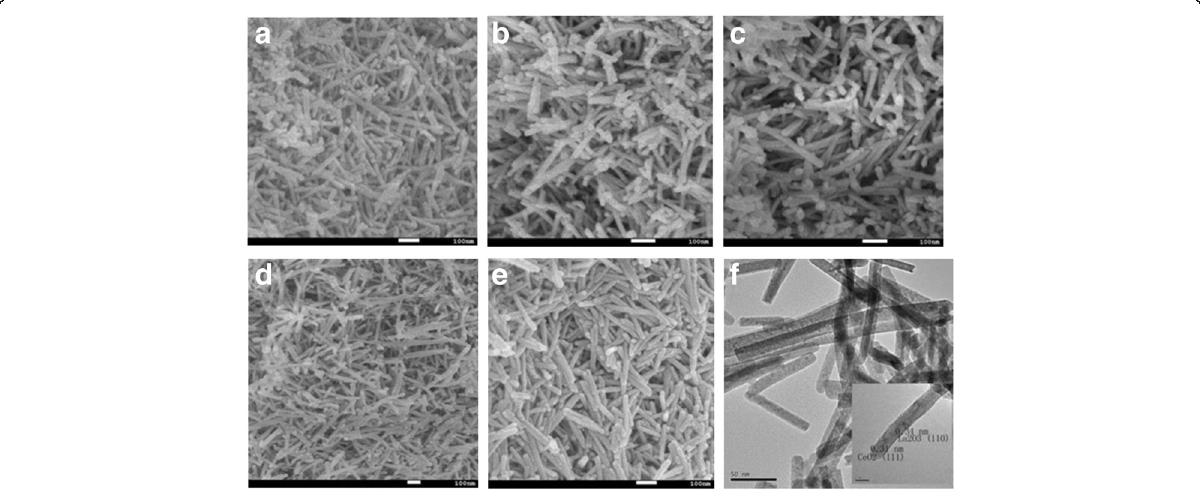
Fig. 3 SEM images of Ce-La nanorods with different La contents: 0 ( a ), 25 at.% ( b ), 50 at.% ( c ), 75 at.% ( d ), 100 at.% ( e ); TEM image of Ce 0.50 -La 0.50 nano- rods ( f ); and the inset shows corresponding HRTEM image